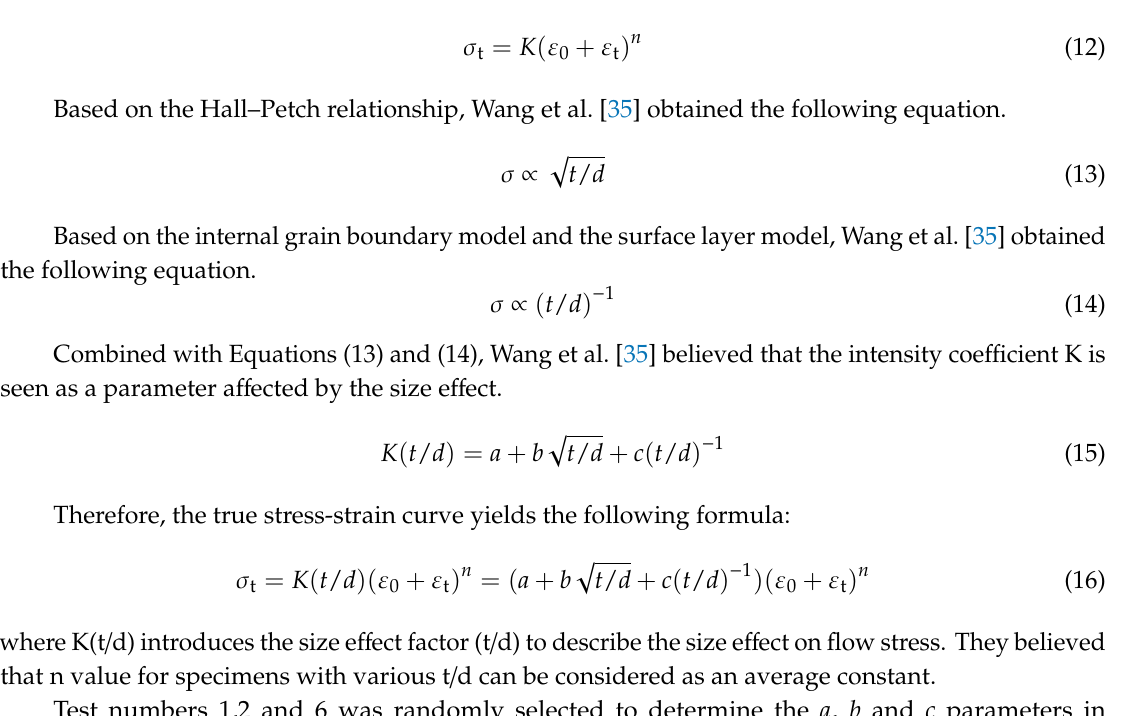
Figure 6. True stress–true strain curves of specimens with various t/d. Table 1. Material parameters for the Swift model.